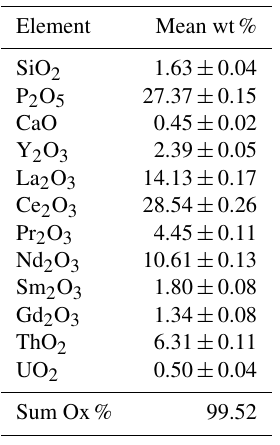
Table 1. Average electron microprobe analyses of Harcourt gran- odiorite monazite grains.